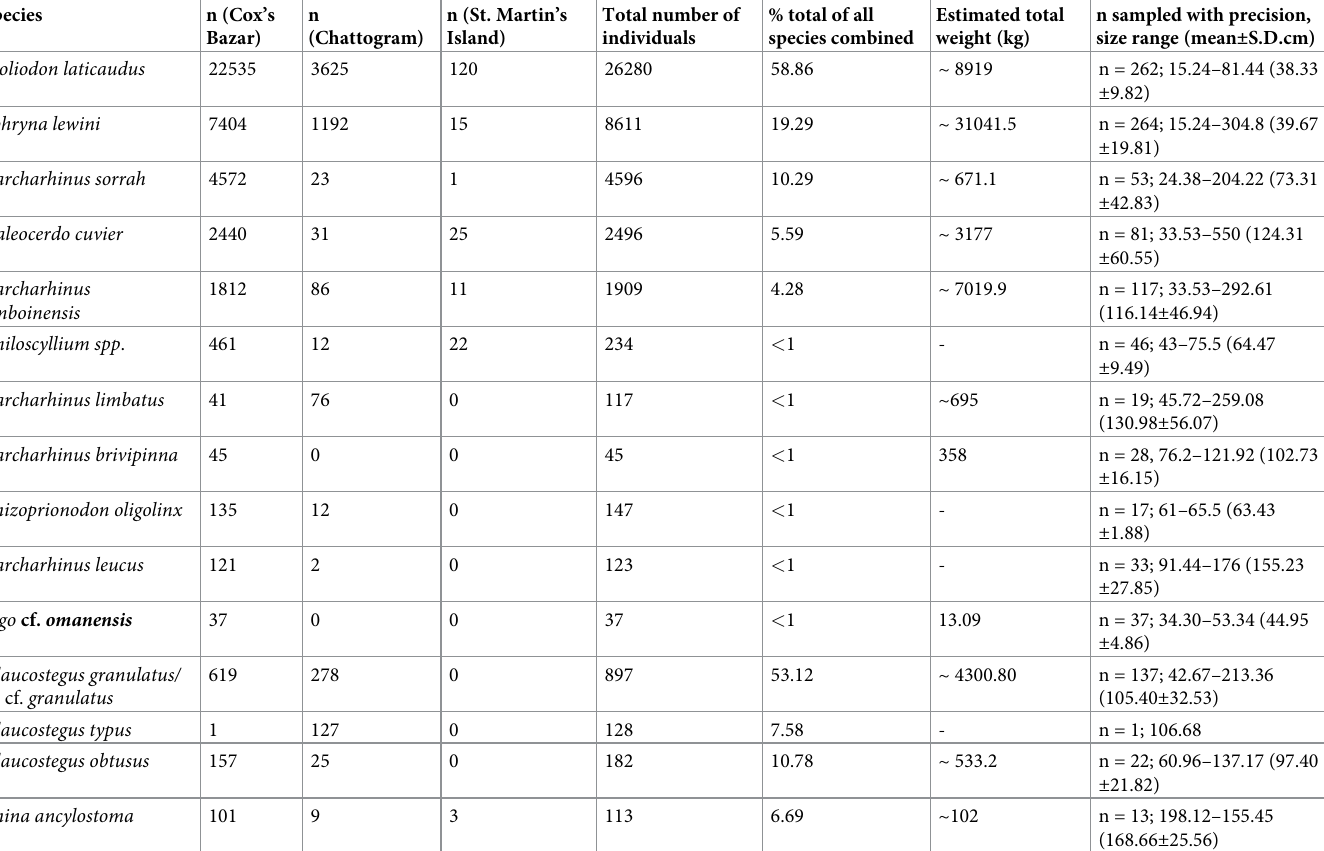
Table 2. Total number (n) and percentage of total (%) of species (elasmobranchs) identified to species level and recorded from Chattrogram, Cox’s Bazar and St. Martin’s Island during the study period (January 2017 to June 2017). Species n (Cox’s n n (St. Martin’s Total number of % total of all Estimated total n sampled with precision, Bazar) (Chattogram) Island) individuals species combined weight (kg) size range (mean ±